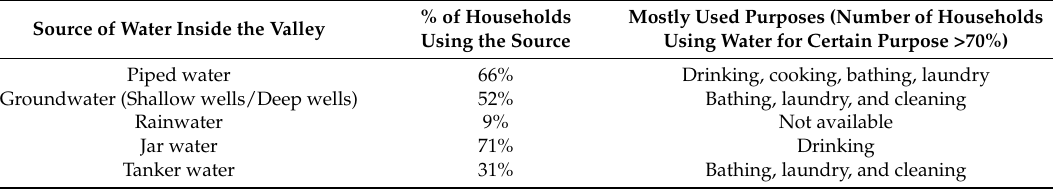
Table 2. Water sources inside the valley and their use preferences.